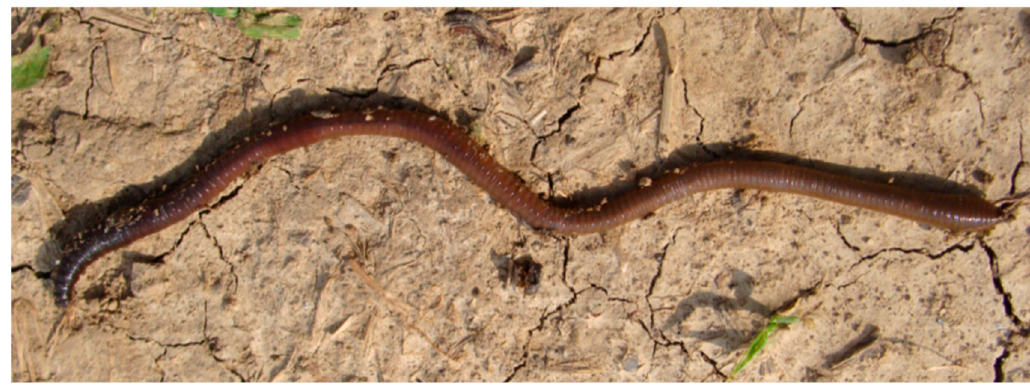
Figure 15. Example of earthworm that can be used for ecotoxicity assessment.